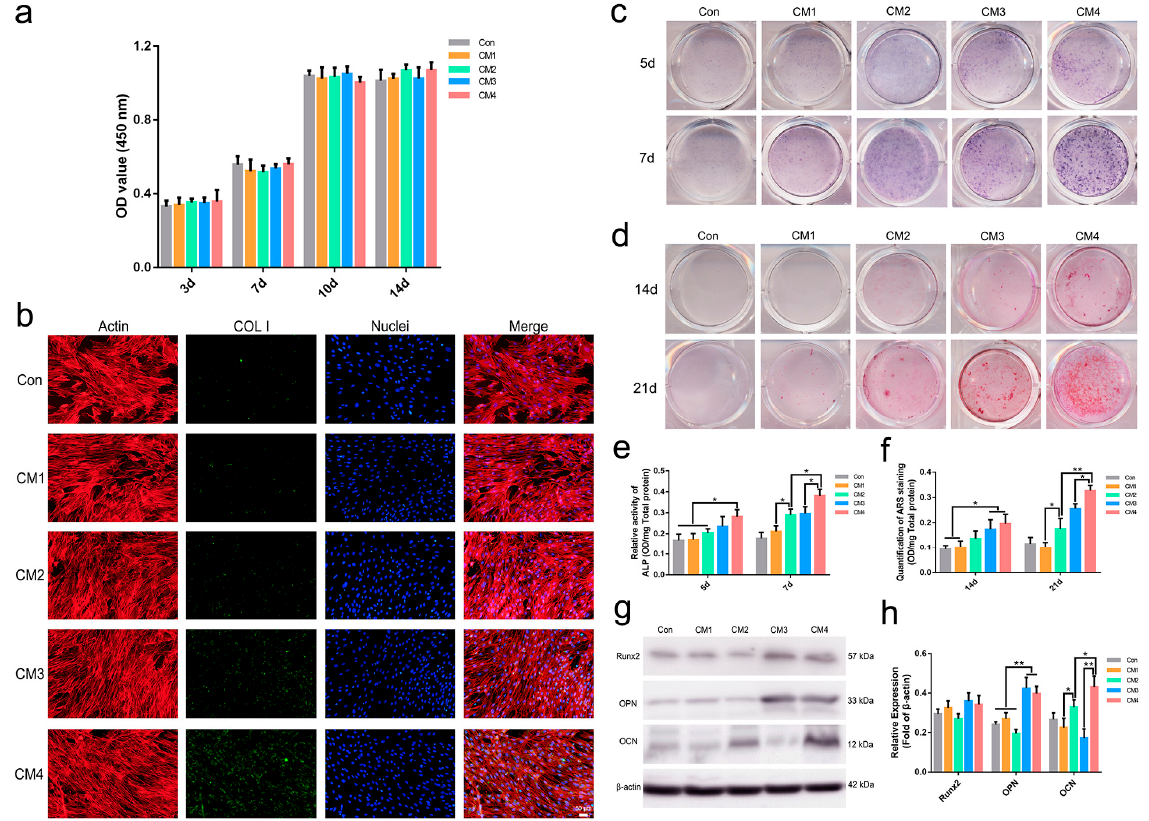
Figure 4. MSC activity and differentiation. ( a ) Viability of MSCs in each group; ( b ) immunofluo- rescence staining of COL-I in MSCs cultured in various CMs; ( c ) ALP staining of MSCs cultured in various CMs; ( d ) ARS staining of MSCs cultured in various CMs; ( e ) relative ALP activity of MSCs cultured in various CMs; ( f ) quantification of the ARS staining of MSCs cultured in various CMs; ( g ) Western blotting results for the expression of Runx2, OPN and OCN in MSCs cultured in various CMs; ( h ) quantification of the Western blotting